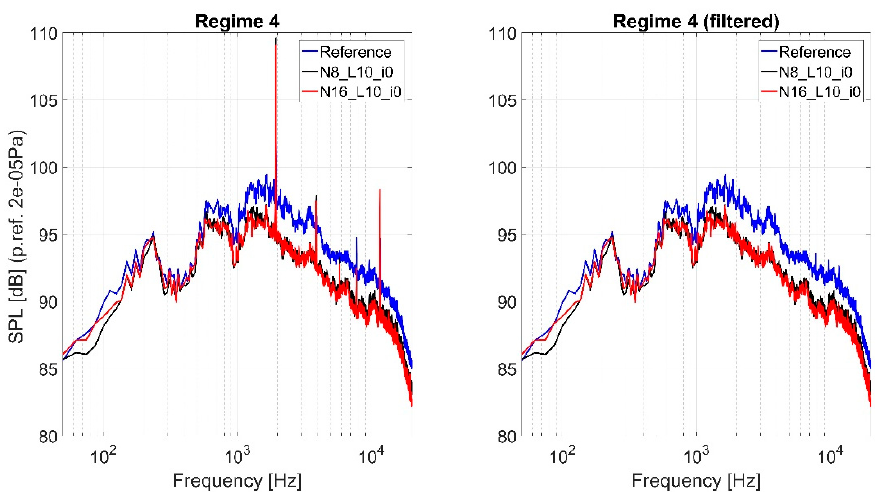
Figure 4. Averaged noise spectra for each configuration and regime.